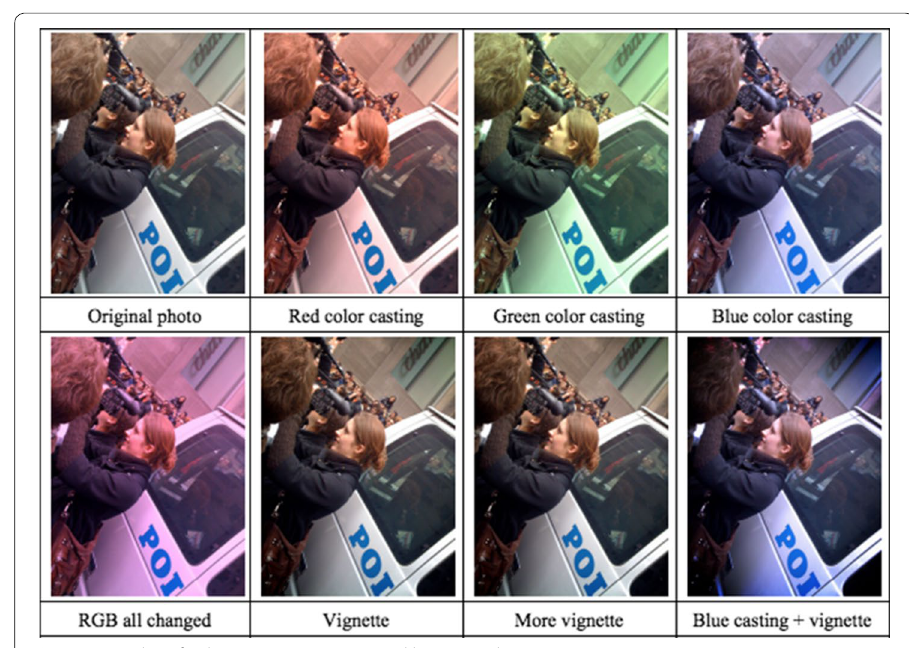
Fig. 4 Examples of color augmentations tested by Wu et al.